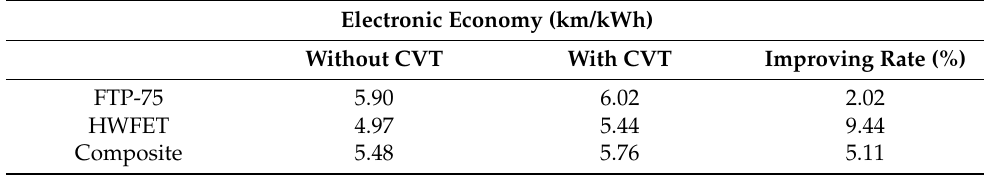
Figure 13. Comparison of energy efficiency according to CVT’s time constant. Table 6. Comparison of electric economy between driving cycles.